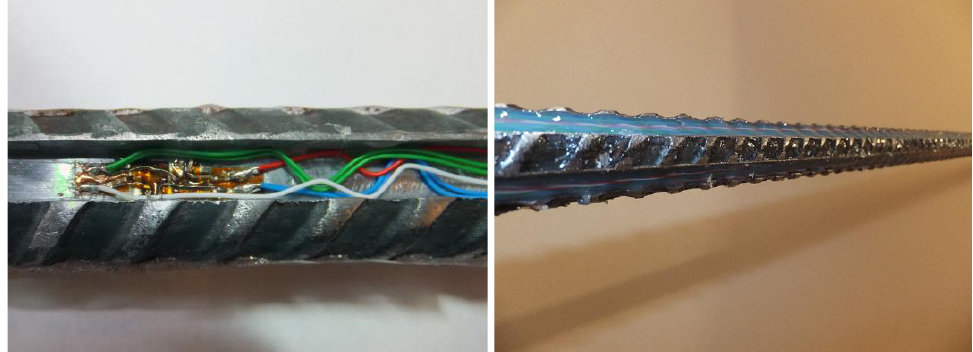
Figure 4. Connection of strain gauges on the anchor ( left ) and protection against weather conditions and impact ( right ).